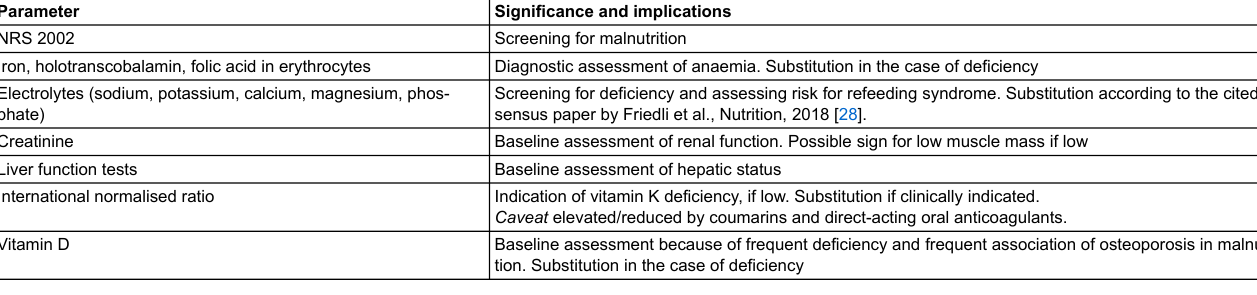
Table 1: Basic assessment at admission.